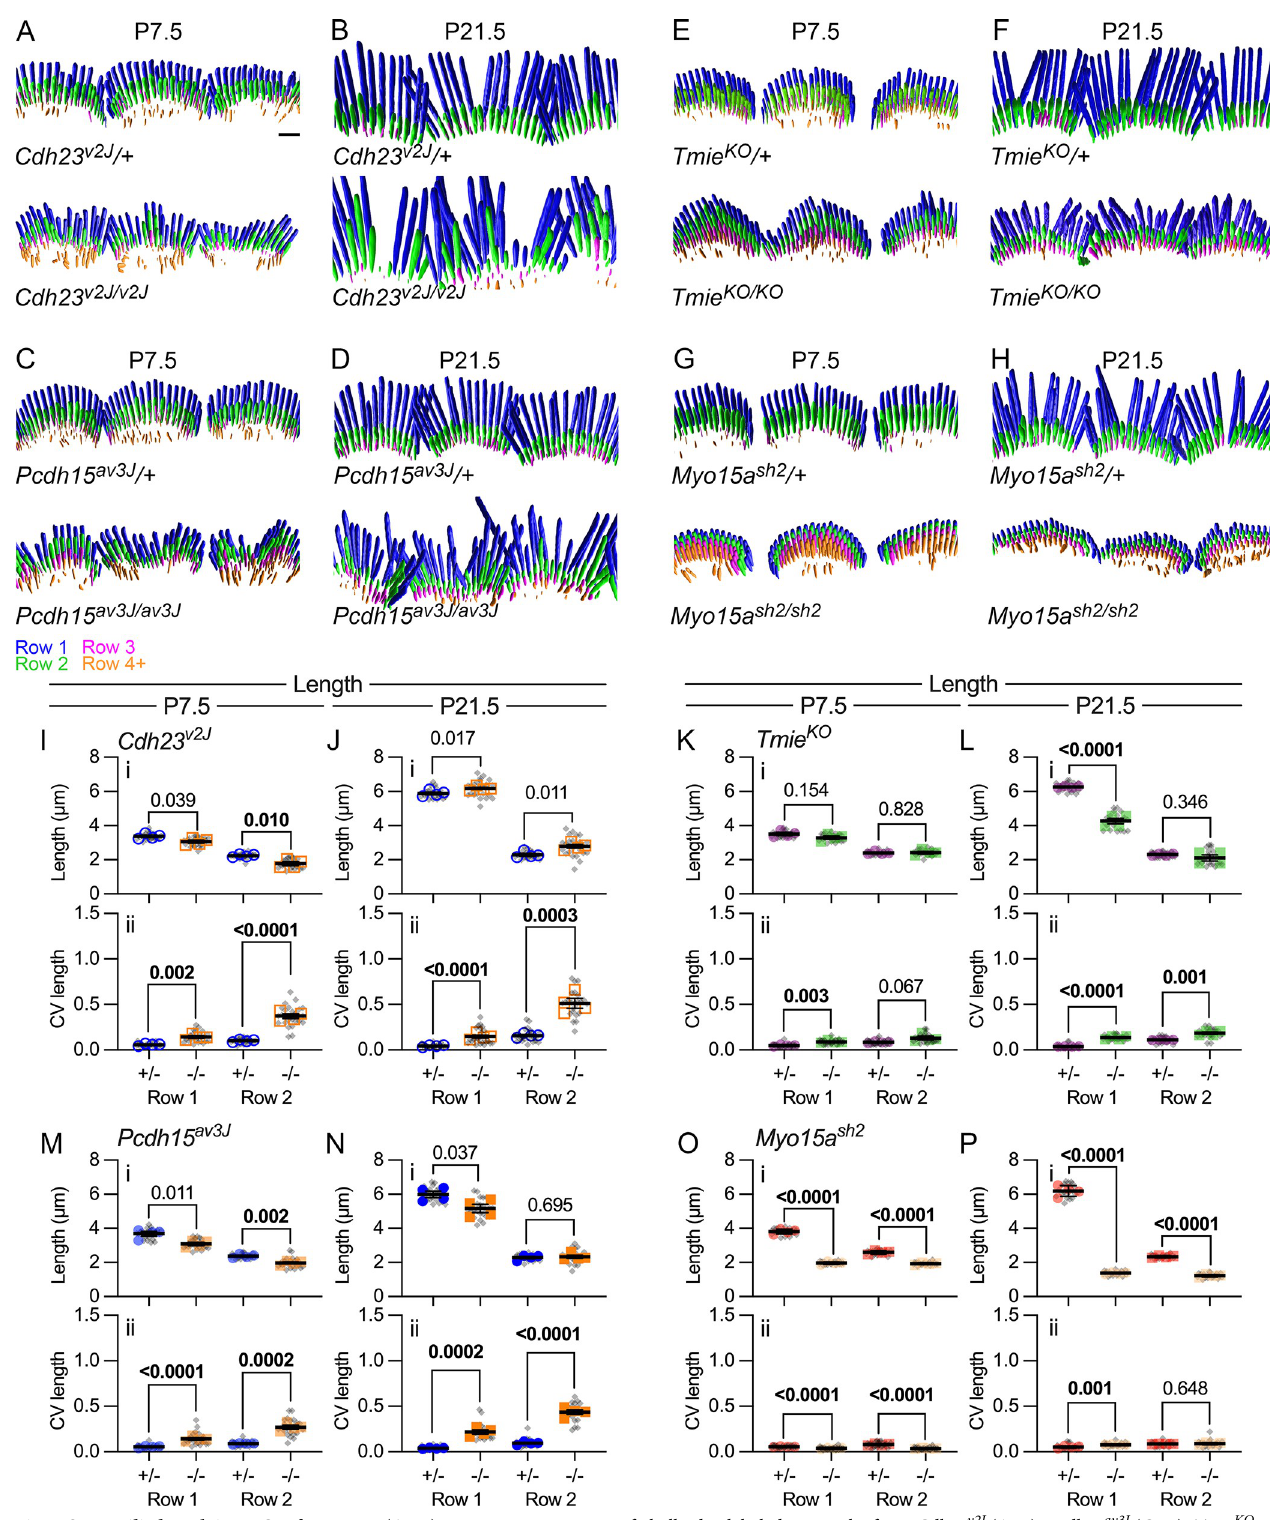
Fig 3. Stereocilia length in IHCs of mutants. ( A–H ) Imaris reconstruction of phalloidin-labeled stereocilia from Cdh23 v2J (A, B), Pcdh15 av3J (C, D), Tmie KO (E, F), and Myo15a sh2 (G, H) IHCs at P7.5 and P21.5. Stereocilia surfaces are color-coded according to row; scale bar in A (2 μ m) applies to all panels. ( I–P ) Average stereocilia length (panels labeled i) and CV (ii). Length measurements used reconstructed stereocilia surfaces. Lengths were determined for the center